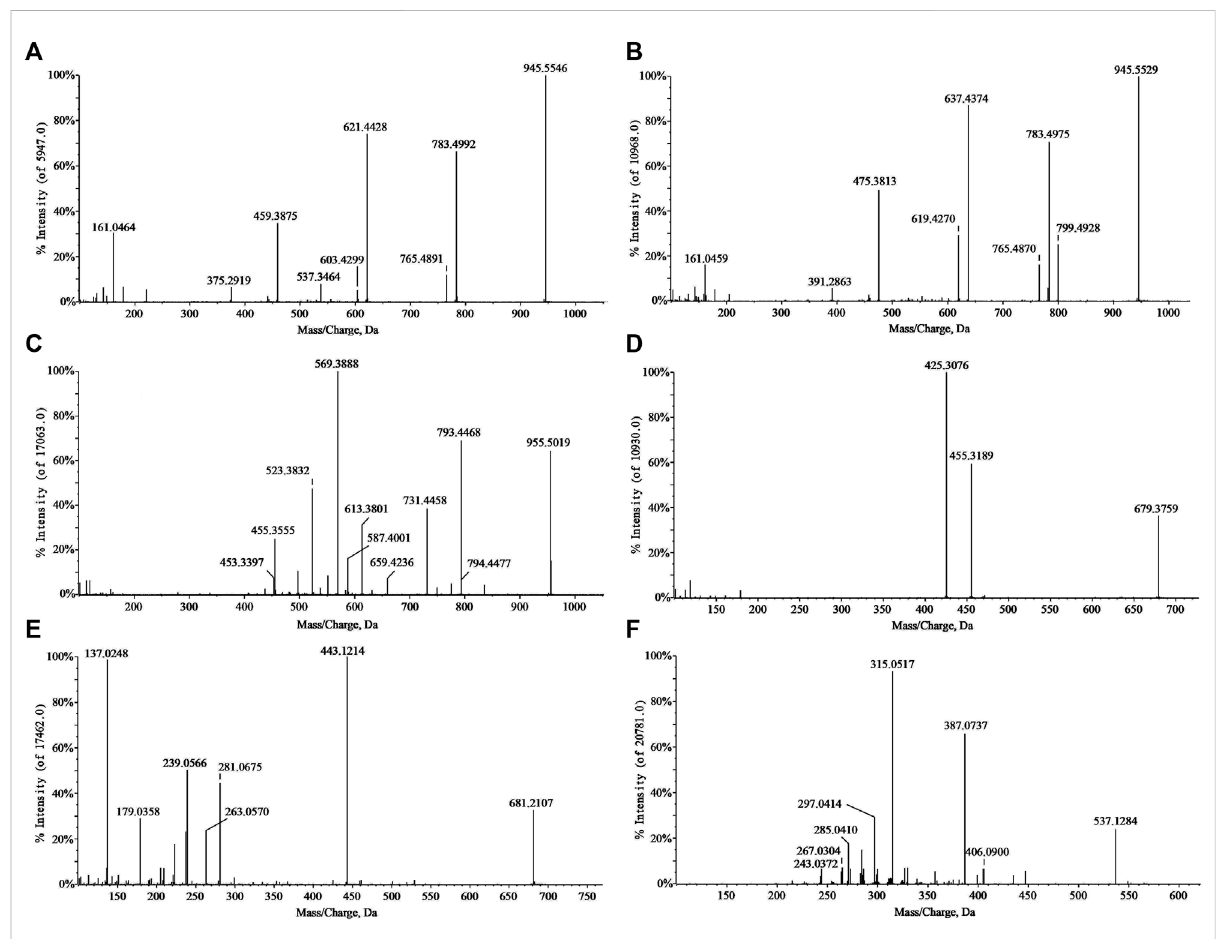
FIGURE 2 MS/MS spectra of standard substances. GRd (A) ; GRe (B) ; GRo (C) ; Ten (D) ; TenA (E) ; and SB (F)